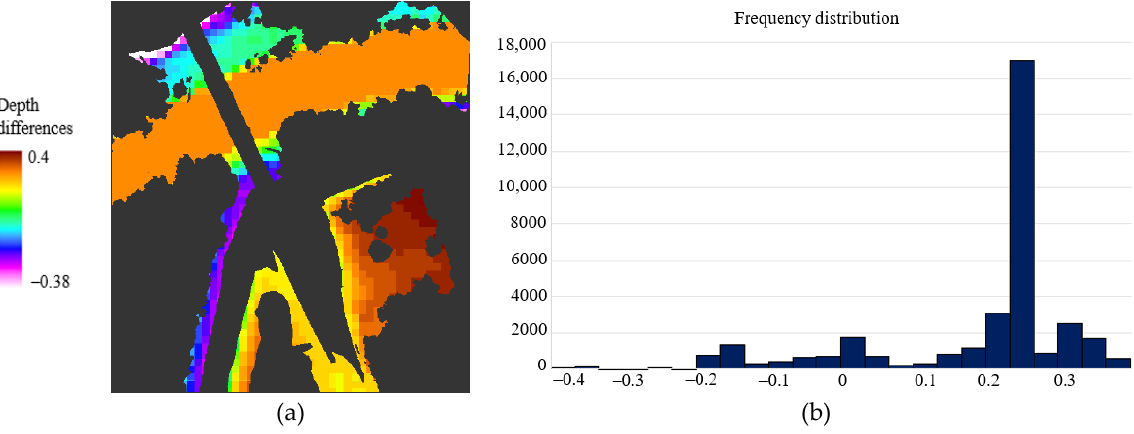
Figure 8. Floodwater depth comparison. ( a ) Water depth difference between method 2 and method 1; ( b ) a histogram that shows frequencies distributions of the flood depth difference between the two methods.